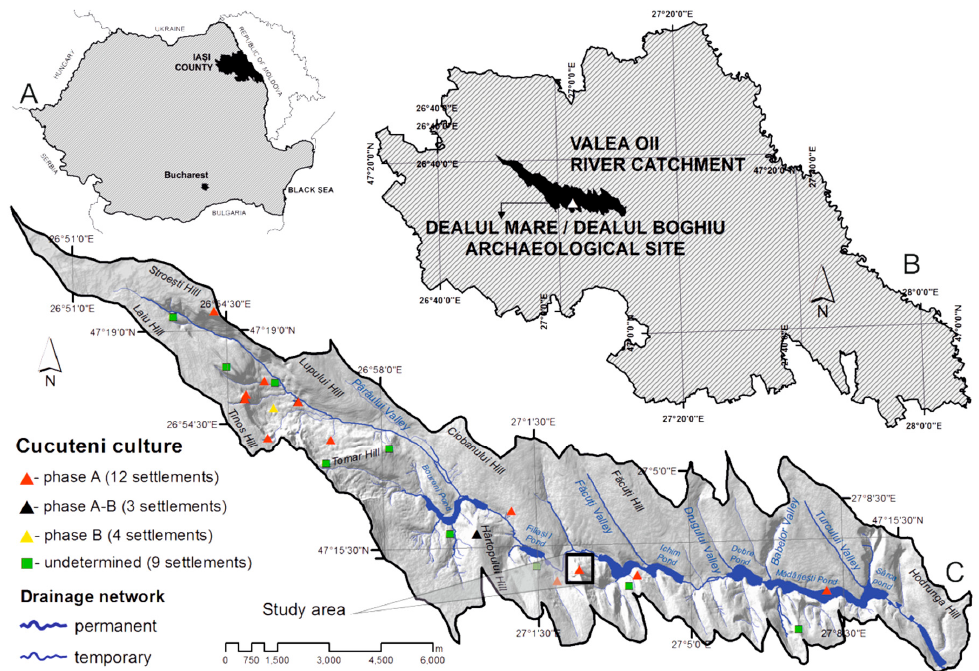
Figure 1. The location of the study area in Romania ( A ), Ia ș i County ( B ) and the Valea Oii basin ( C ); (2.5 m/pixel resolution Digital Elevation Model (DEM) and hydrological network—Nicu, C.).